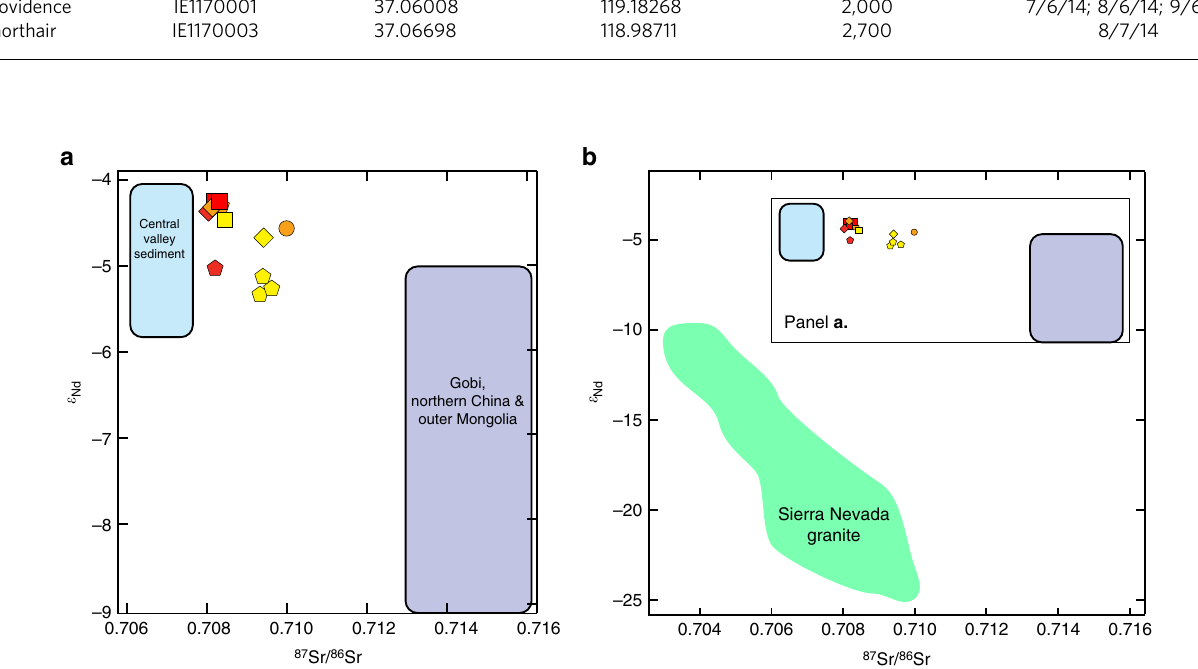
Figure 2 | Strontium and neodymium dual isotope plot. Isotopic compositions of Sierra Nevada dust samples are plotted in context of literature derived potential source area isotopic compositions ( a ) Central Valley and Asia ( b ) including Sierra Nevada granite 25,29,32 . External reproducibility (2 s.d.) of new data are smaller than the symbol size; errors for literature data are 0.5–1.0 e Nd . Symbols for the four sites match those in Fig. 1: circles are Shorthair (elevation B 2,700m); pentagons are Providence (elevation B 2,000m); diamonds are Soaproot (elevation B 1,100m); and squares are San Joaquin Experimental Range (elevation B 400m). Colours reflect passage of time during the sampling interval: yellow (July), orange (August) and red (September). The relatively radiogenic composition and small range in e Nd indicates that local, Sierra Nevada granite provides negligible dust emission and deposition to these sites ( b ); dust is a combination of regional Central Valley sources and global Asian sources ( a